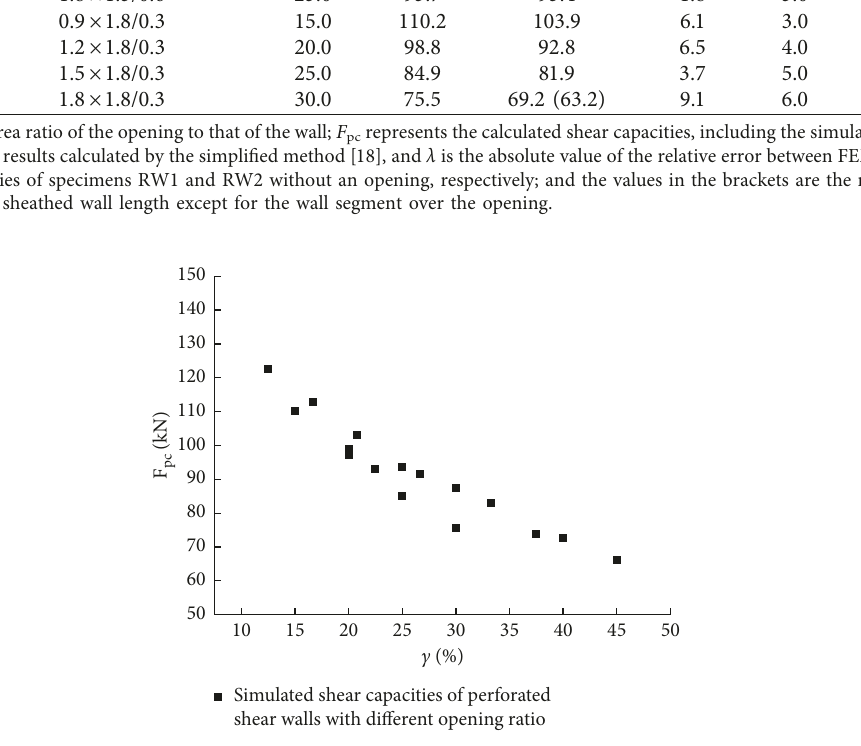
Figure 6: Shear capacity of the walls with different opening